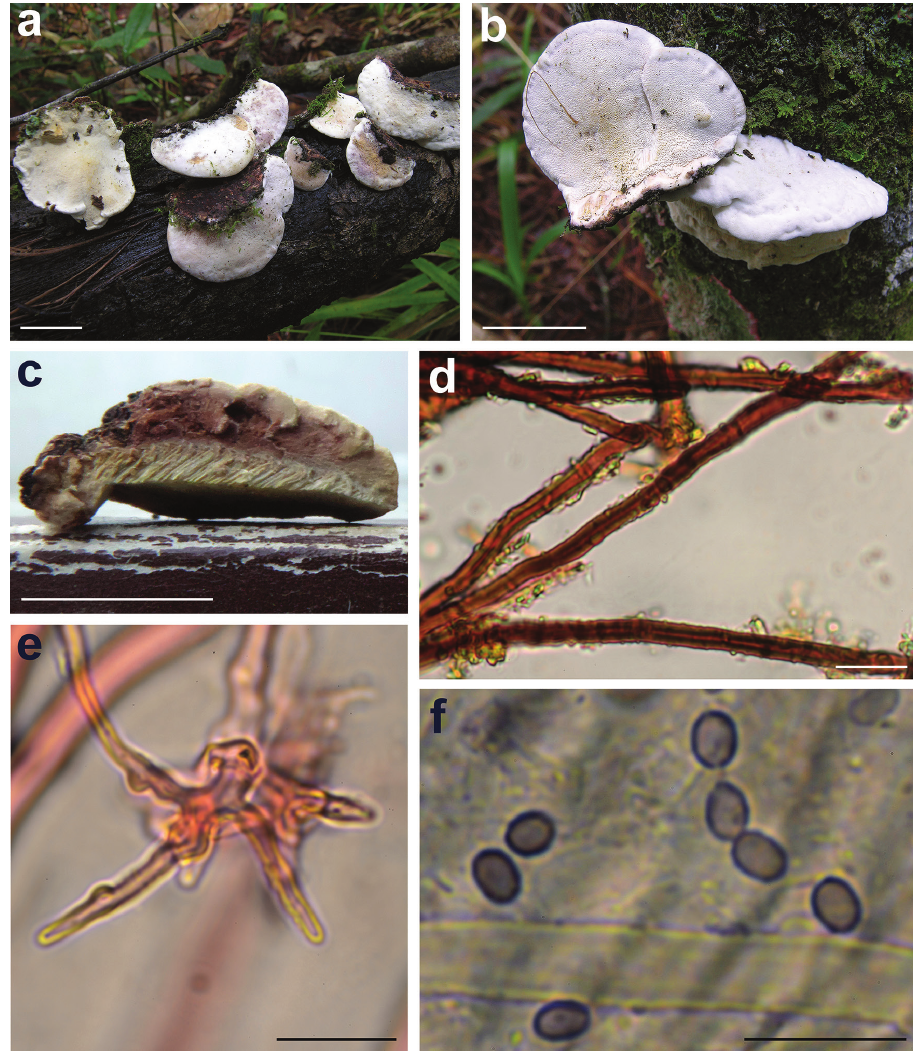
Figure 3. Pseudowrightoporia dominicana (JBSD 127410) a, b fresh basidiomes in situ c cut side of the basidiome d dextrinoid skeletal hyphae e binding hypha f amyloid spores. Microscopical elements ob- served in Melzer’s anionic reagent. Scale bars: 10 mm ( a–c ); 10 µm ( d–f ).